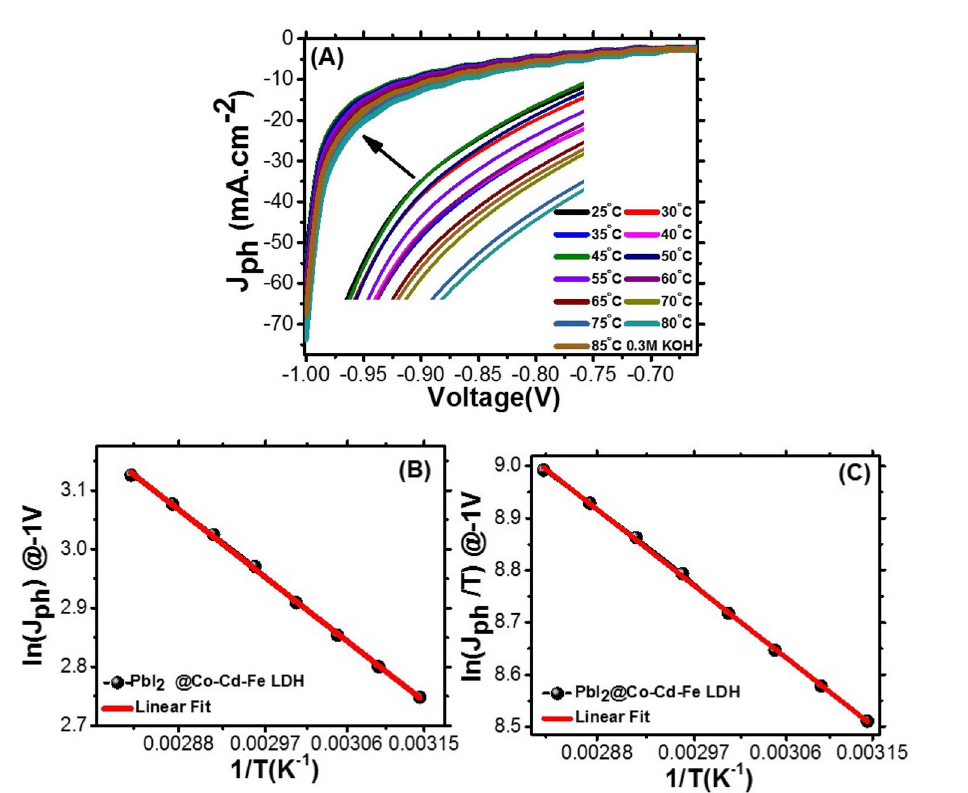
Figure 13. Effect of applied temperature on the PEC J ph –voltage curves ( A ), plots of Ln (J ph /T) vs. 1/T ( B ), and plots of Ln (J ph ) vs. 1/T ( C ) for T-LDH/PbI 2 NC